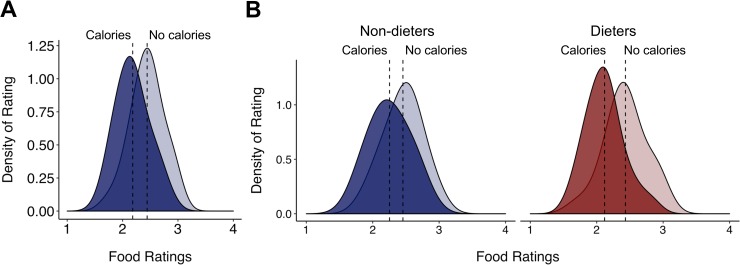
(A) Ratings of willingness to eat foods presented in images with NO CALORIES and with CALORIES. Willingness to eat was lower when presented with calories—and this difference was greater for dieters than non-dieters. (B) Food ratings by dieting status.